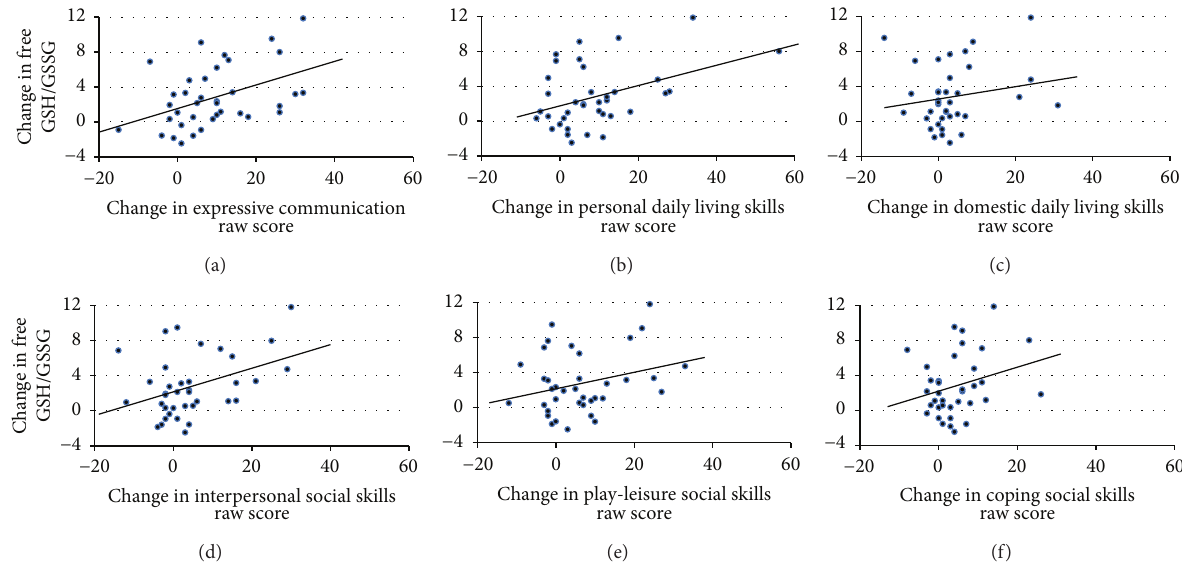
Figure 3: Significant relationships between the change in the glutathione redox status (reduced-to-oxidized glutathione ratio) and change in subscales of the Vineland Adaptive Behavior Scale (VABS) subscales. An improvement in glutathione redox status was associated with improvement in (a) expressive communication ( 𝐹(1,33) = 9.66, 𝑃 < 0.01 ), (b) personal daily living skills ( 𝐹(1,34) = 12.84, 𝑃 = 0.001 ), (c) domestic daily living skills ( 𝐹(1,34) = 4.69, 𝑃 < 0.05 ), (d) interpersonal social skills ( 𝐹(1,34) = 10.47, 𝑃 < 0.005 ), (e) play-leisure social skills ( 𝐹(1,34) = 8.16, 𝑃 < 0.01 ), and (f) coping social skills ( 𝐹(1.34) = 6.09, 𝑃 < 0.05 ). The moderating effect of glutathione redox status on the VABS subscale is provided in the graph as a representation of the relationship between the variables. Since the linear models examining the moderating effect of glutathione redox status on the VABS subscale takes into account age, simple correlation coefficients would not be accurate for inclusion in the graphs.